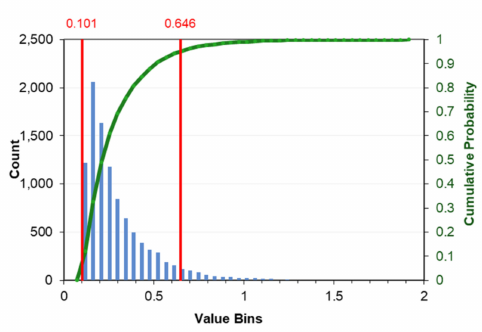
Figure 17. Histogram of Simple Payback Period through MCS on Cantilever